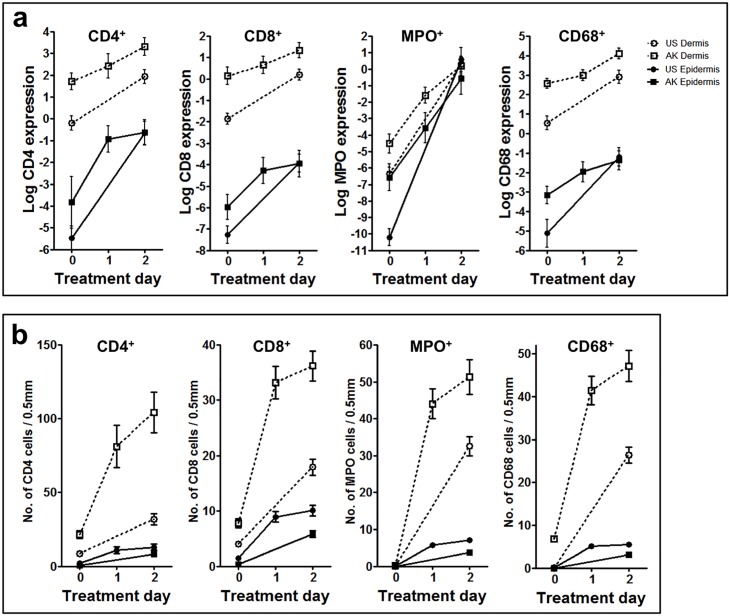
Cells of the adaptive and innate immune system increase strongly upon topical treatment with ingenol mebutate 0.05% gel.For detailed quantification, two complementary quantitative analyses were conducted to ensure high-quality measurements. Automated histomorphometric analyses (A) and manual counting of positive cells (B) were performed on all samples (actinic keratosis [AK] lesions at day 0, day 1, and day 2, and uninvolved skin (US) at day 0 and day 2 from all patients (n = 26). Depicted data represent averages +/- standard error of the mean. There was a statistically significant overall concordance with the two technologies, e.g. for CD4+ epidermis (r = 0.4) and dermis (r = 0.4) and for CD8+ epidermis (r = 0.5) and dermis (r = 0.7). The data for the computer-based histomorphometrical analysis were logarithmically transformed. Statistical significance was determined by analysis of variance for: CD4+ T-lymphocytes, epidermis/dermis AK0 versus AK2 (P = 0.0007/P = 0.0006), US0 versus US2 (P < 0.0001/P < 0.0001) and for US2 versus AK2 (not significant [NS]/P < 0.0001), CD8+ T-lymphocytes, epidermis/dermis AK0 versus AK2 (P = 0.0024/P = 0.0019), US0 versus US2 (P < 0.0001/P < 0.0001), and for US2 versus AK2 (NS/P = 0.0065), CD68+ macrophages/histiocytes, dermis (epidermis was NS) AK0 versus AK2 (P < 0.0001), US0 versus US2 (P < 0.0001), and for US2 versus AK2 (P = 0.0042), and MPO+ neutrophils, epidermis/dermis AK0 versus AK2 (P < 0.0001/P < 0.0001), US0 versus US2 (P < 0.0001/P < 0.0001), and for US2 versus AK2 (NS/NS). A full statistical overview is available in S1 Table.